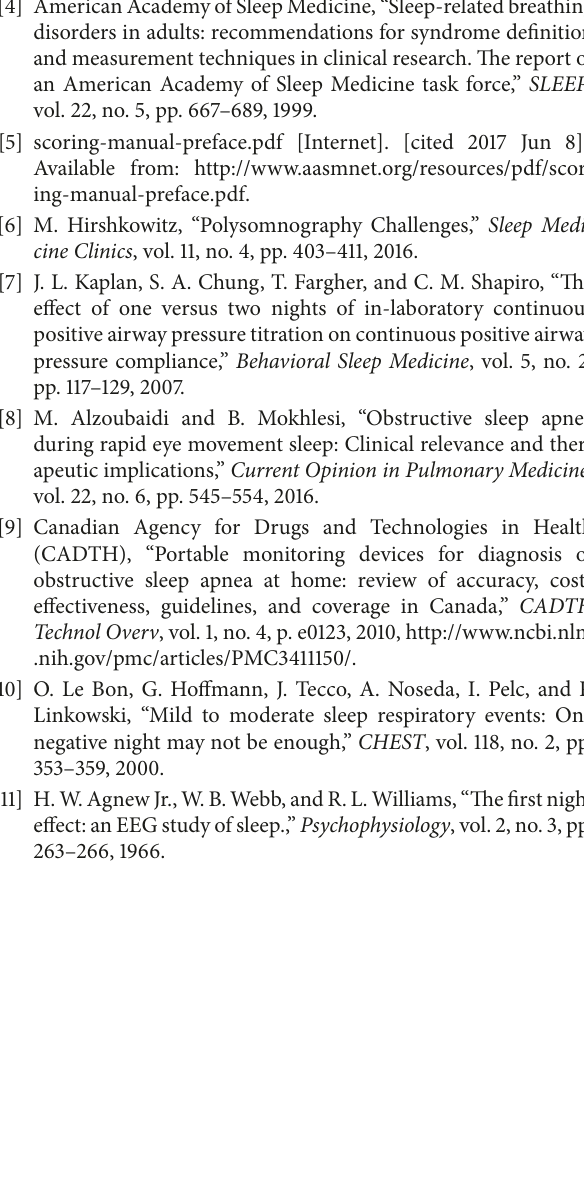
Supplementary Table 1: sleep macro-architecture for the study sample during second night of ambulatory recording. Supplementary Table 2: respiratory parameters for the study sample during second night of ambulatory sleep